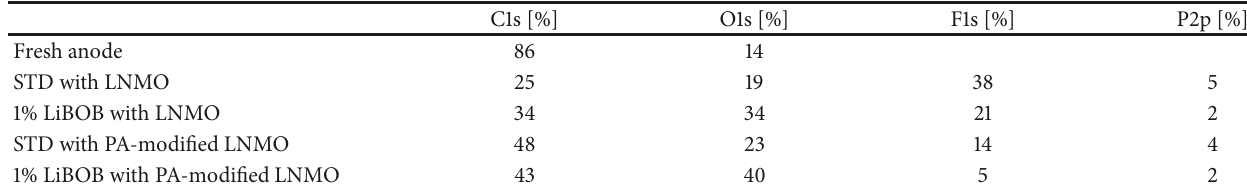
Table 1: Percentage anode elemental concentrations from